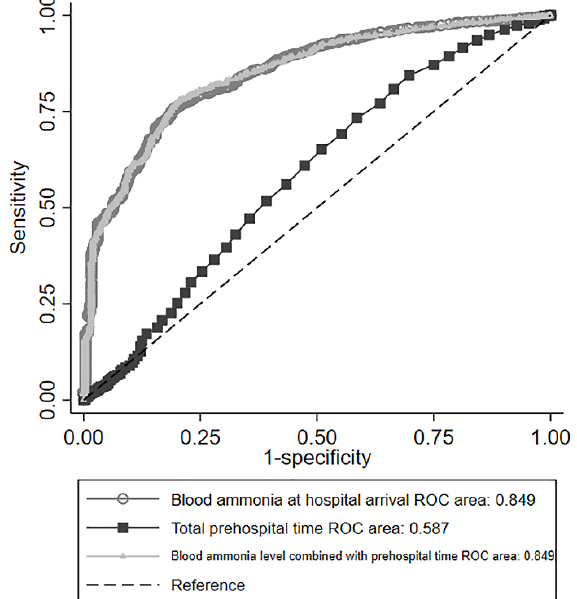
Figure 2. ROC curve for predicting poor outcomes with blood ammonia level (circle), total prehospital time (square), and blood ammonia level combined with total prehospital time (triangle). The areas under the ROC curve are shown in the box. The ROC curve of blood ammonia level at hospital arrival and of blood ammonia level combined with total prehospital time are almost identical. Abbreviations: receiver operating characteristic